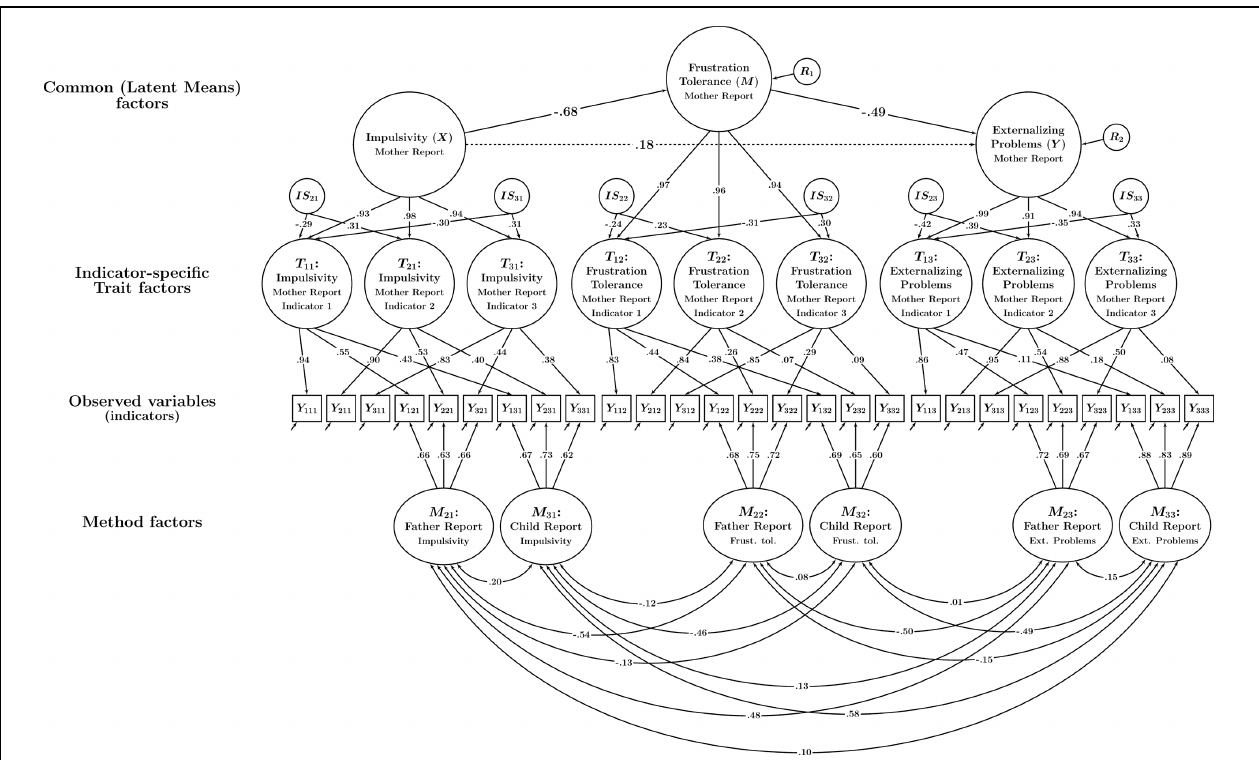
FIGURE 7 | Path diagram illustrating the CT-C( M – 1) mediation model in Figure 6 with standardized parameter estimates obtained for the present